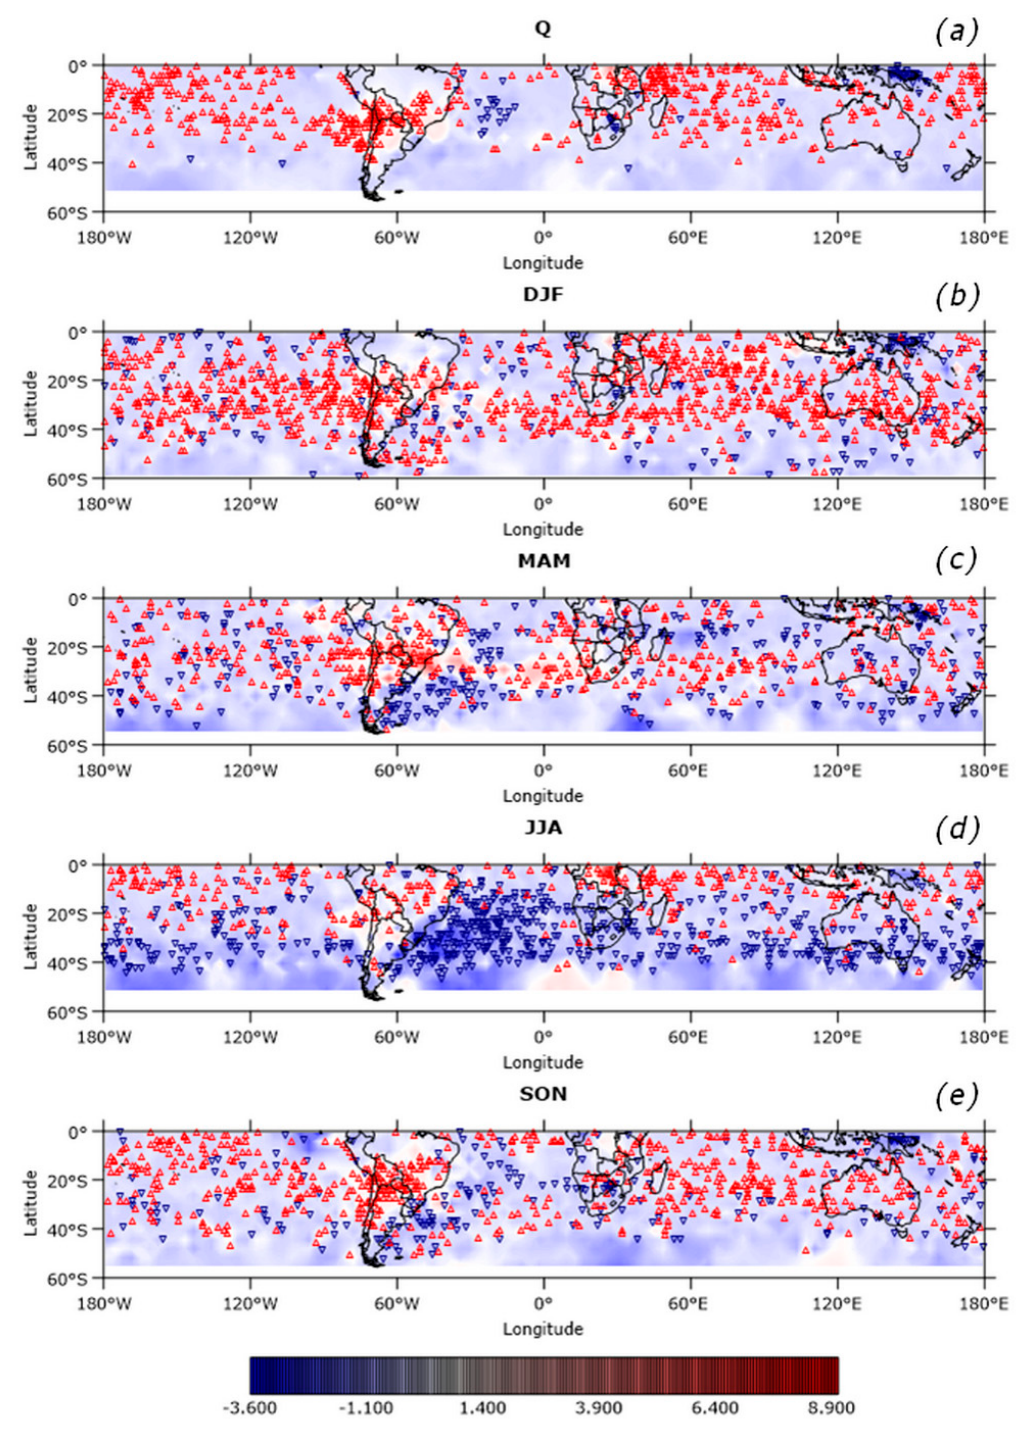
Figure 3. Linear trends (background colours) for the SO 2 seasonal concentrations in the lower troposphere (TRL) (in DU century − 1 ) for ( a ) Q, ( b ) DJF, ( c ) MAM, ( d ) JJA, and ( e ) SON. Red and blue arrows mark the pixels that have a significant monotonic upward and downward trend (not necessarily linear), respectively. A level of significance of 95% was set. As in Figure 2, pixels whose time series had at least a seasonal missing value were not included in the analysis.